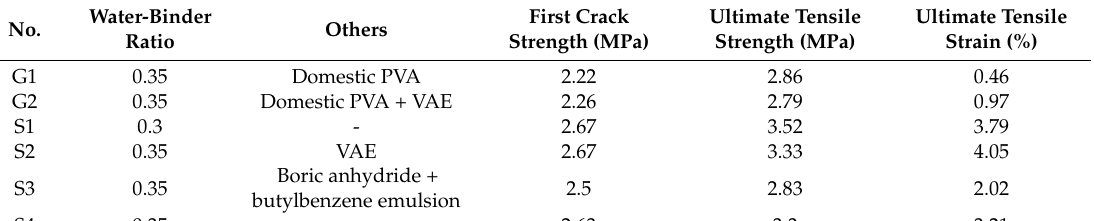
Table 10. Mixture ratio of tensile testing.